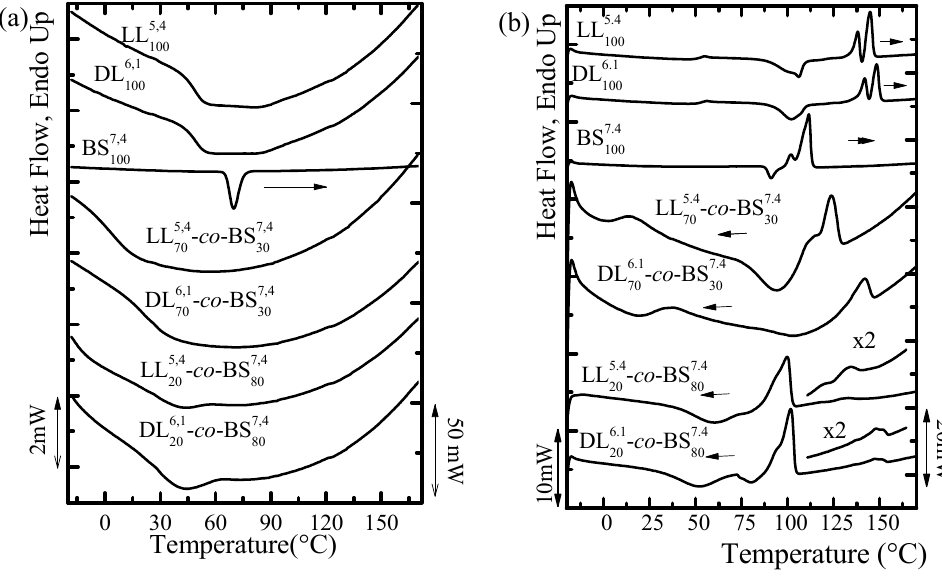
Figure 1. DSC scans at 20 °C/min for the homopolymers and copolymers: ( a ) cooling; and ( b ) second heating.